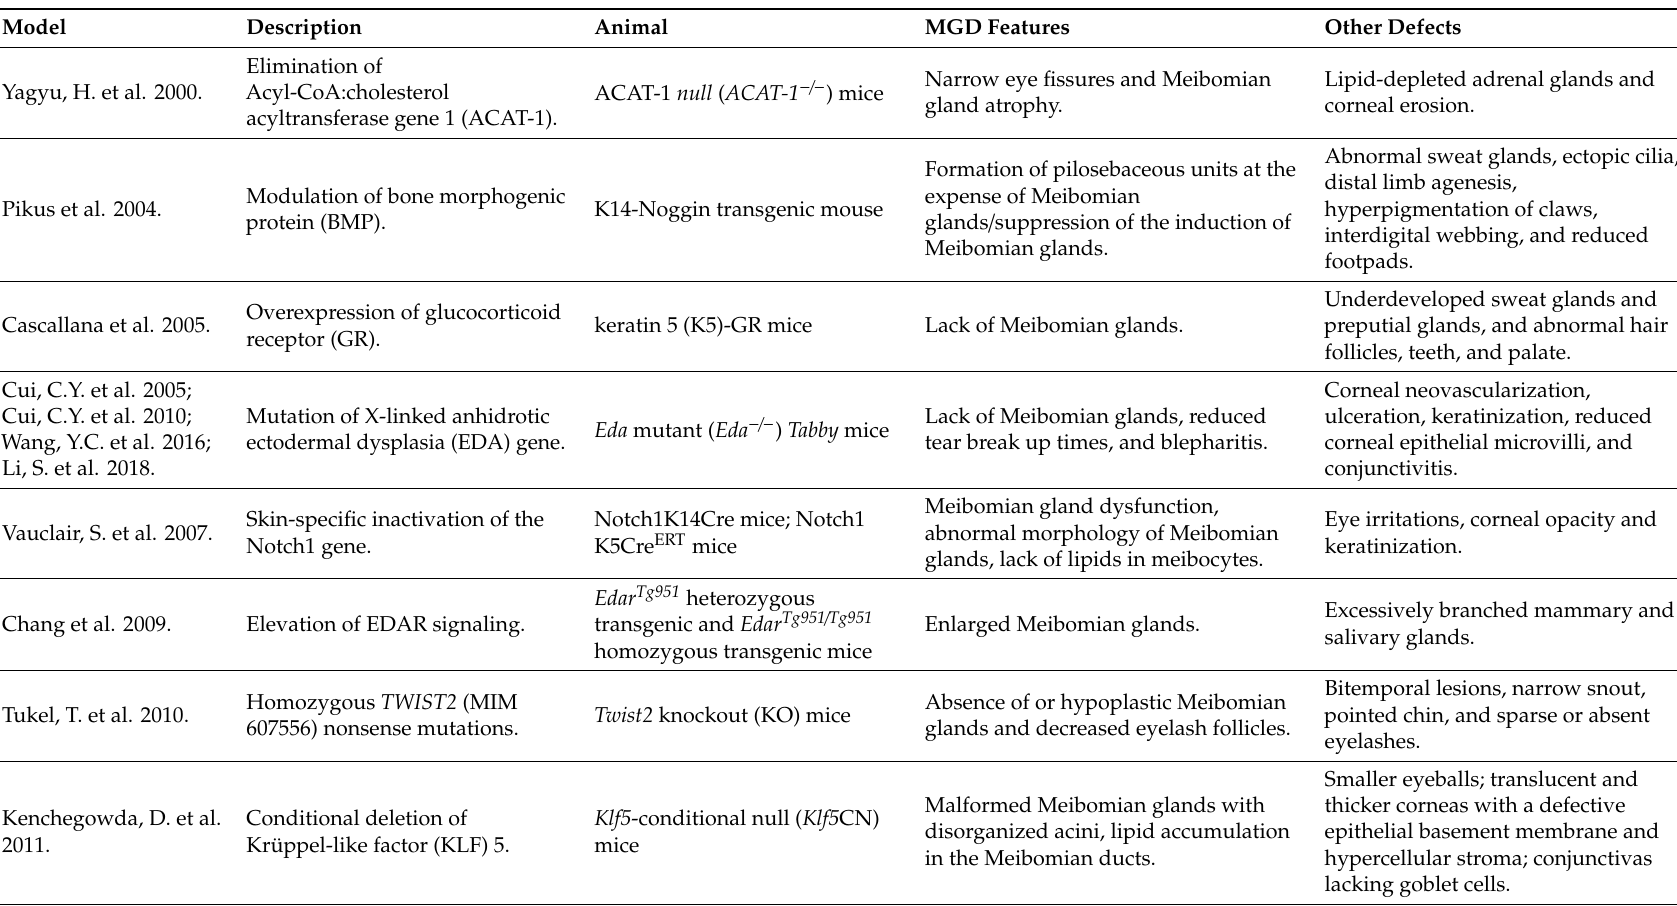
Table 1. Transgenic mouse models with Meibomian gland alterations and / or Meibomian gland dysfunction (MGD)-like features